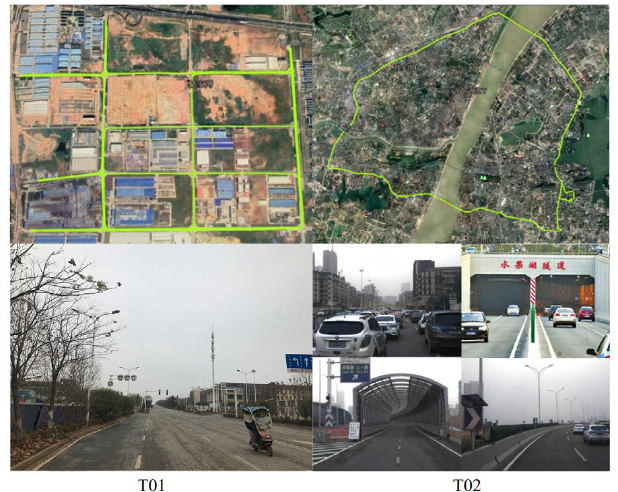
Figure 3. The test trajectory and typical scenarios of T01 (left panel) and T02 (right panel).